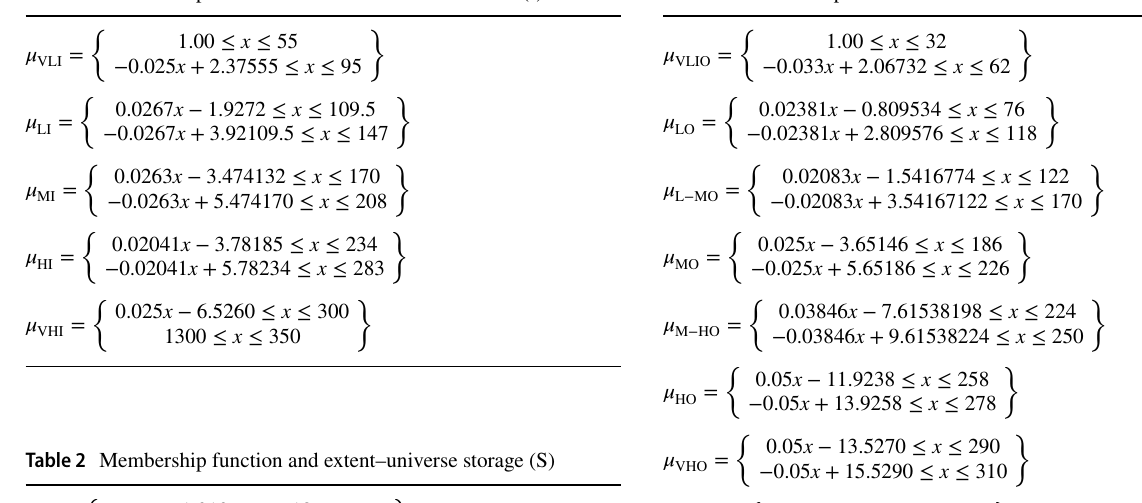
Table 1 Membership function and extent–universe inflow (I)